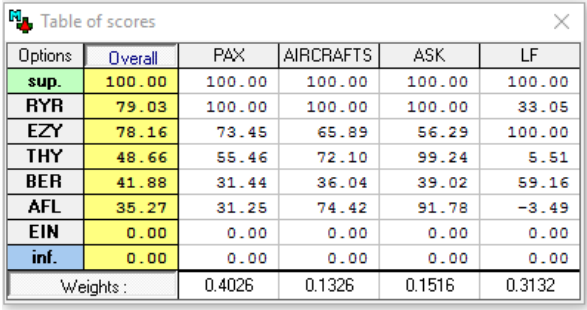
Figure 5: Decision Tree of Transport Performance Area.